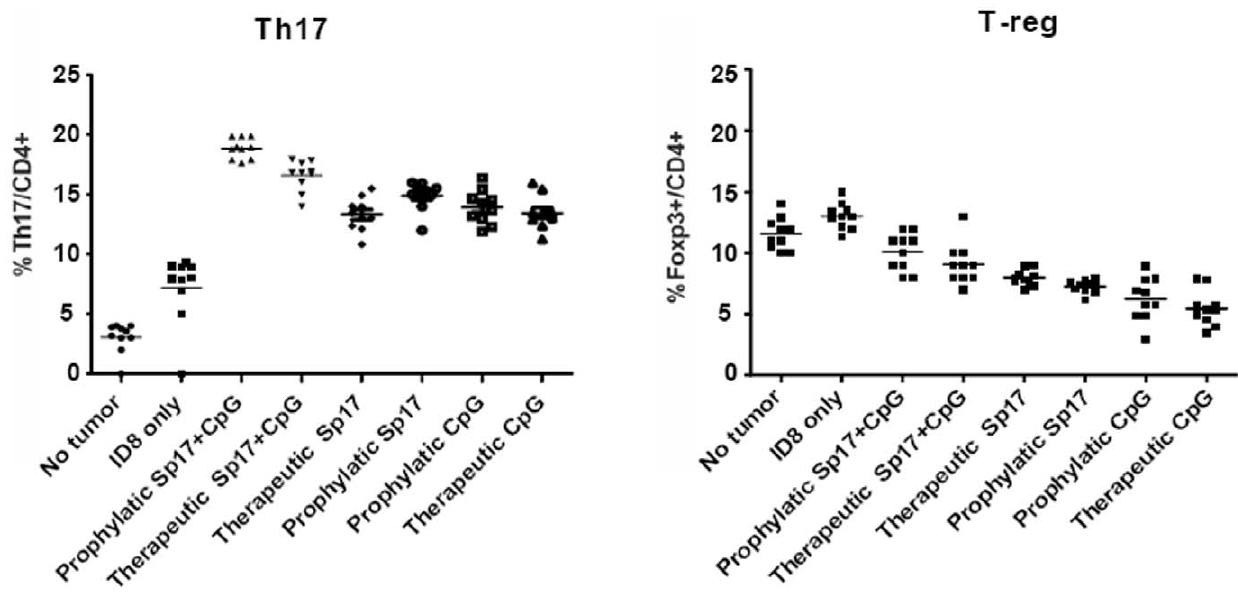
Figure 10. Analysis of Th-17 and T-reg population frequencies. Splenocytes from mice that received prophylactic or therapeutic vaccinations or controls (mice with no tumor or tumor-bearing mice without vaccinations) were collected at different time points (no tumor: day 0; ID8 only: day 45; prophylactic and therapeutic vaccines: day 270) analyzed by flow-cytometry for the measurement of a) Th-17 population (CD4/IL-17-double positive) or b)T-reg population (CD4/Foxp3-double positive) frequency.